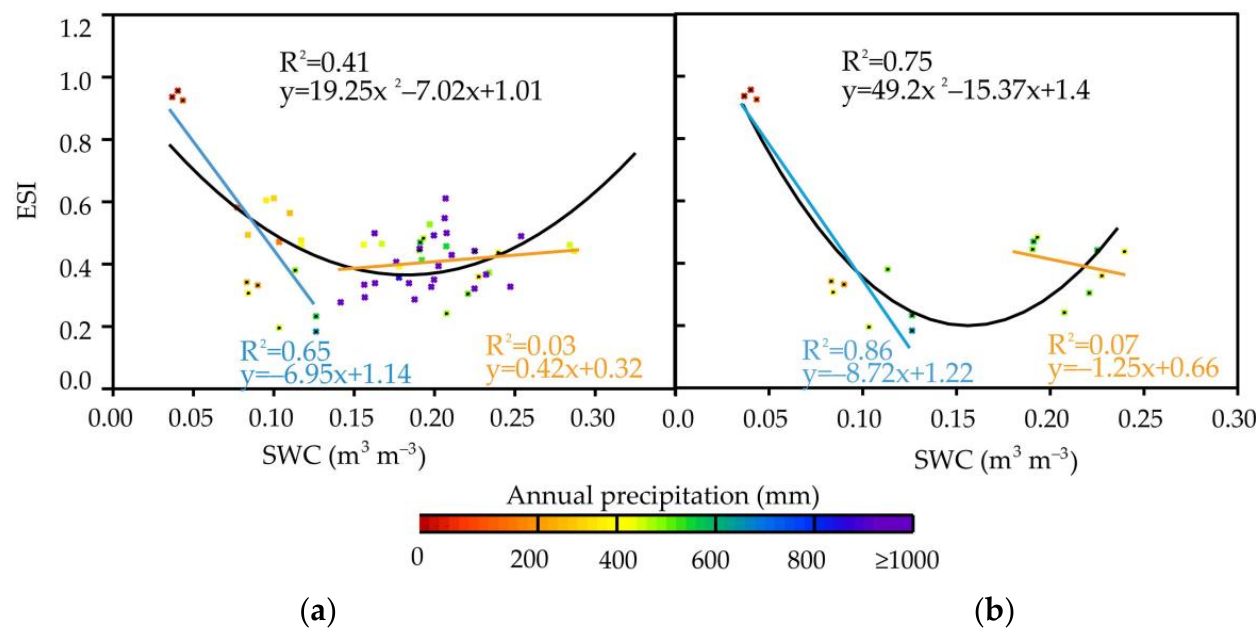
Figure 11. Variation of ESI with SWC at an annual scale. ( a ) is the data of all sites and ( b ) is the data of the alpine zones. The blue fitting line indicates the data of NM and SACOL stations, the orange fitting line indicates the data of other stations, and the black fitting line indicates the data of all stations.